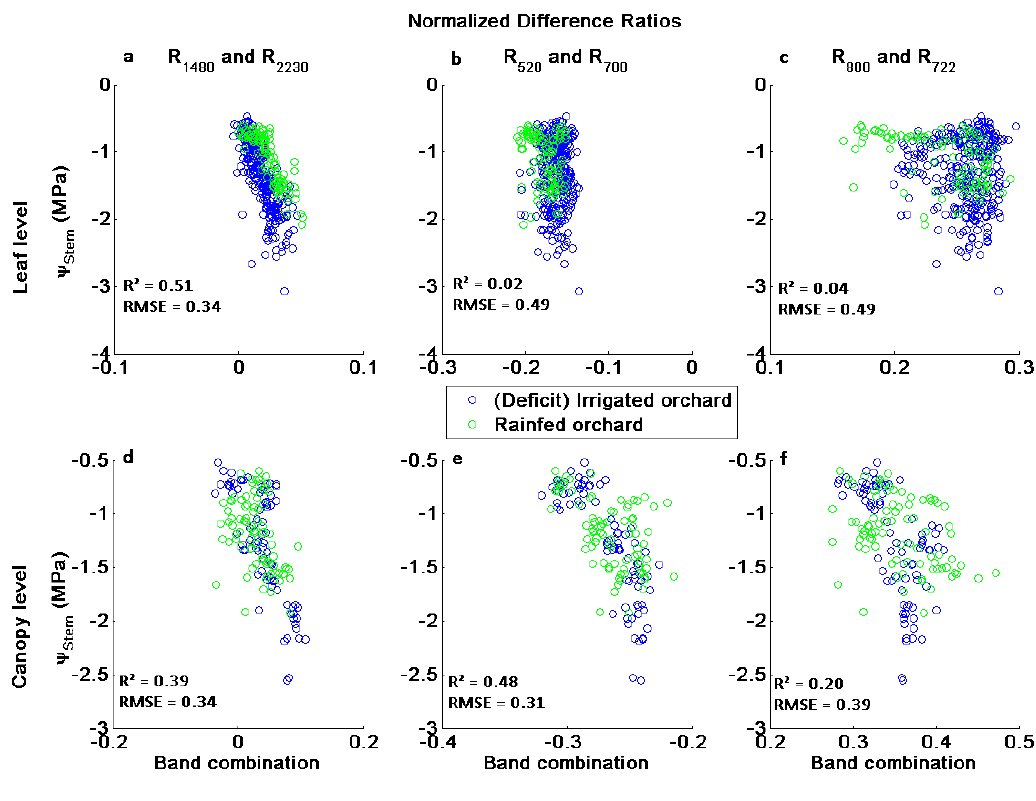
Figure 3. ( a – f ) Scatter plot of normalized difference (Equation (1)) of R and R nm (b,e); R and R nm (c,f); with measured stem water potential (a,d); R 520 700 800 722 ; MPa). All points were labeled for ( Ψ stem